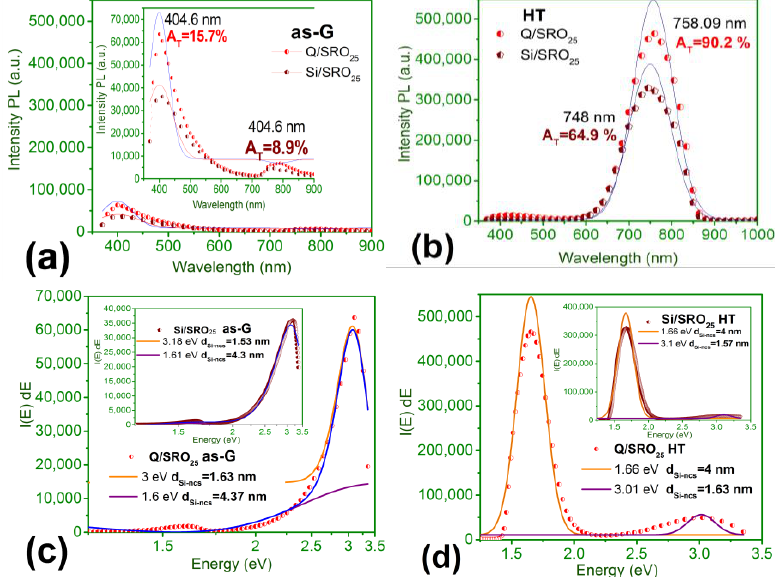
Figure 9. Photoluminescence of the single-layers SRO 25 films deposited by the HFCVD system under conditions ( a ) and ( c ) as-G and ( b ) and ( d ) with HT.